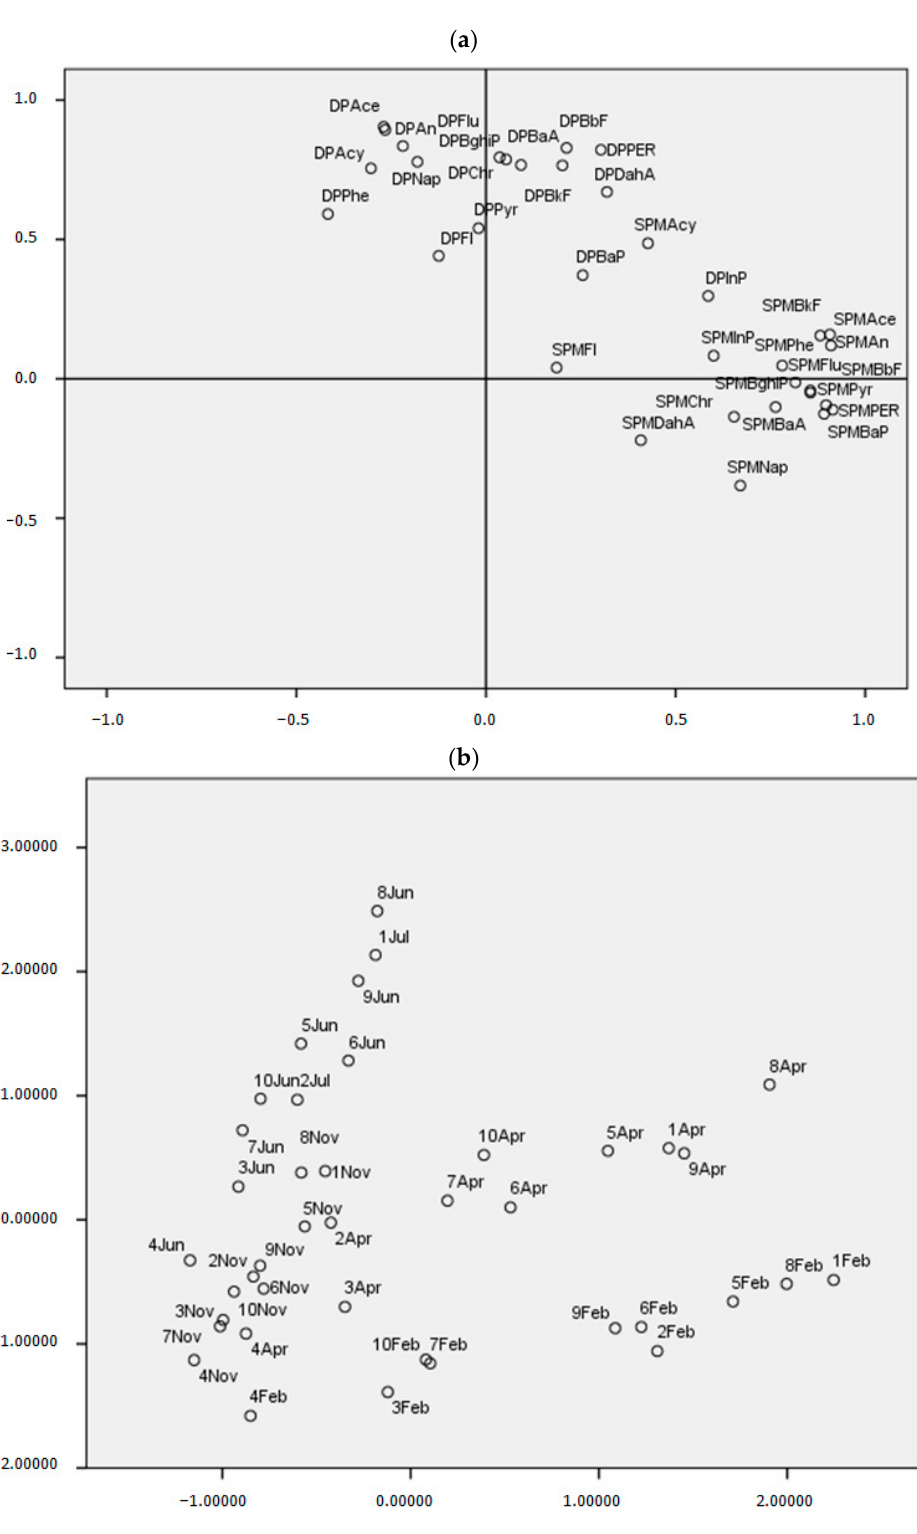
Figure 5. ( a ) Principal component analysis of the DP and SPM data of the Volturno River. Score plot for the first and second principal component. ( b ) Principal component analysis of the DP and SPM data of the Volturno River. The loading plot for the first and second principal component.